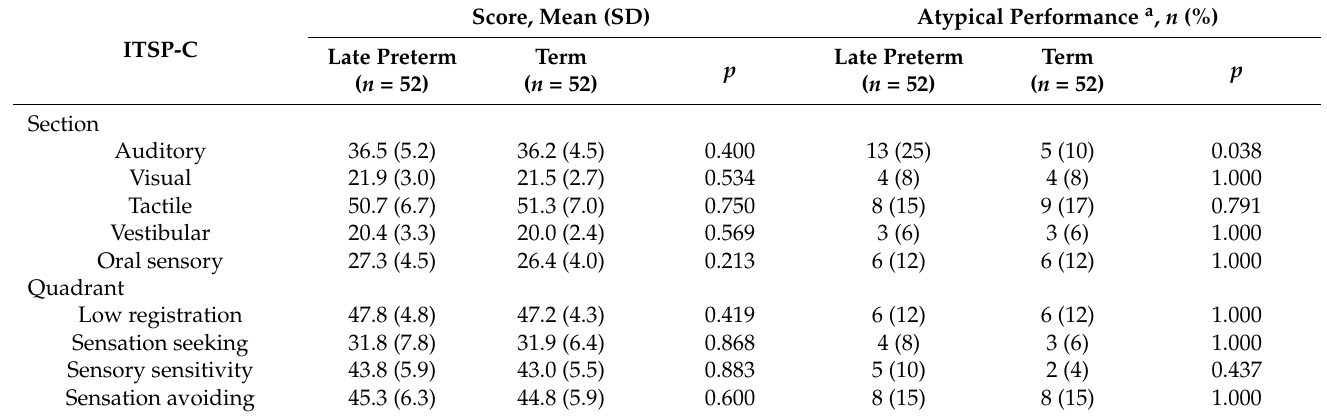
Table 2. Performance on the ITSP-C in the late preterm and term groups.